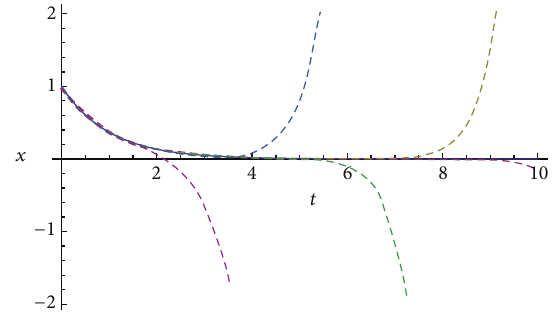
Figure 3: Plots of the exact solution 𝑥 3 (𝑡) and the RPS solutions (𝑡) , 𝑘 = 5, 10, 15, 20 , for (33) and (34) on [0, 10] , where 𝑥 𝑥 𝑘 3 𝑥 𝑘 (𝑡) are represented, respectively, by straight and dashed 3